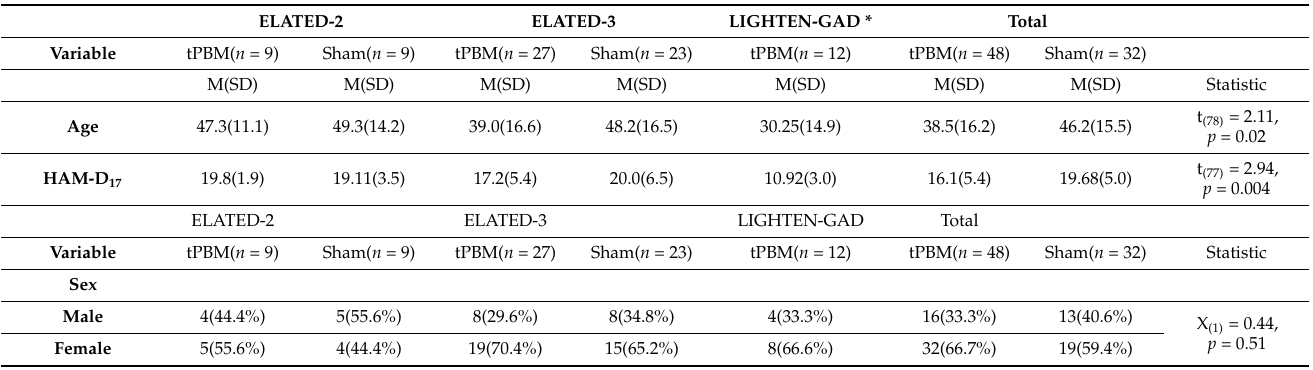
Table 2. Demographic characteristics of the